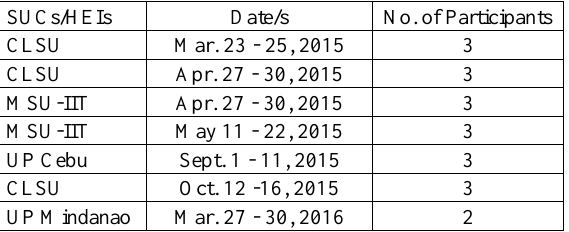
Table 5. Joint fieldworks conducted by PHD